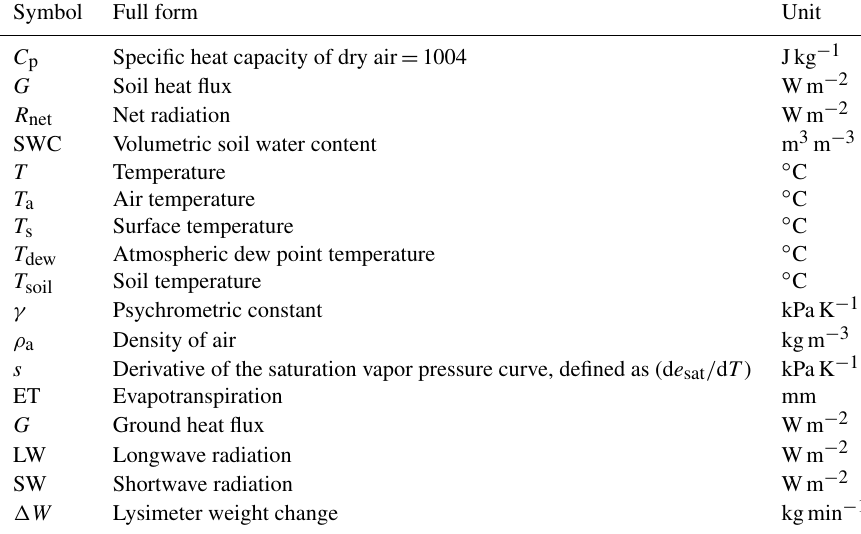
Table B1. List of